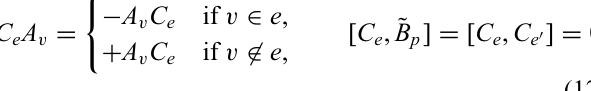
FIG. 2. Vertex term A v , plaquette terms B p , modified plaquette terms ˜ B p , boson hopping operators C e , semion hopping operators X e , and flippers F p , defined with respect to the O edge of p . Each operator is a tensor product of qudits, with a legend shown at the bottom. Edges with two colors represent a product of the two operators, with Z -type operators preceding X type. All operators have an overall phase of + 1 except the X e operators that have an overall e − i π/ 4 phase. A polynomial representation of these operators is given in Appendix